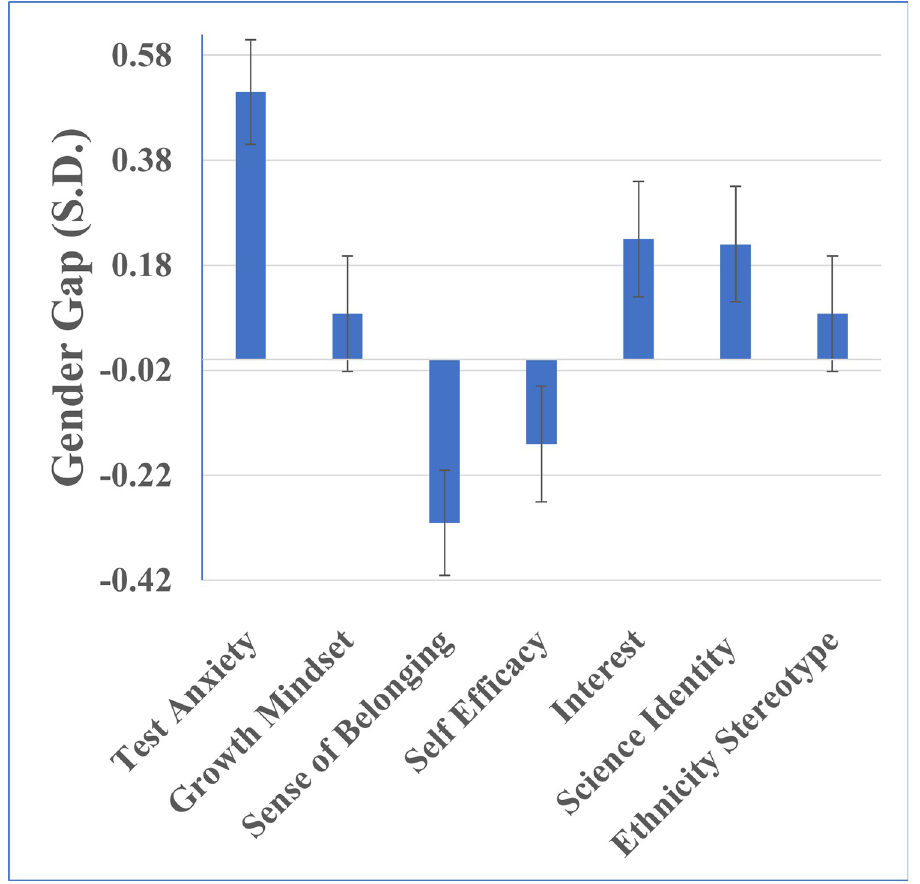
Fig 2. Gender gaps on social psychological constructs. Positive values indicate the female students score higher on that construct than male students. Error bars are the standard error of the coefficient. � p < 0.05, �� p < 0.01, ��� p <